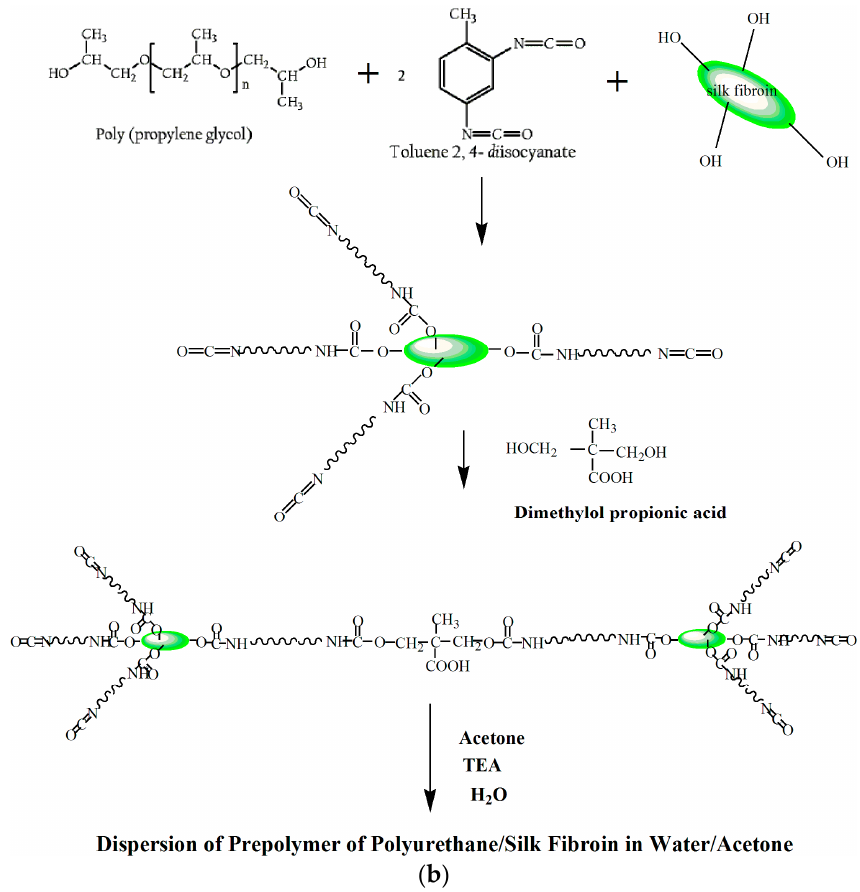
Figure 1. Schematic representation of the preparation of: ( a ) WPU Prepolymer and ( b ) the WPU-SF dispersions in Water/Acetone.